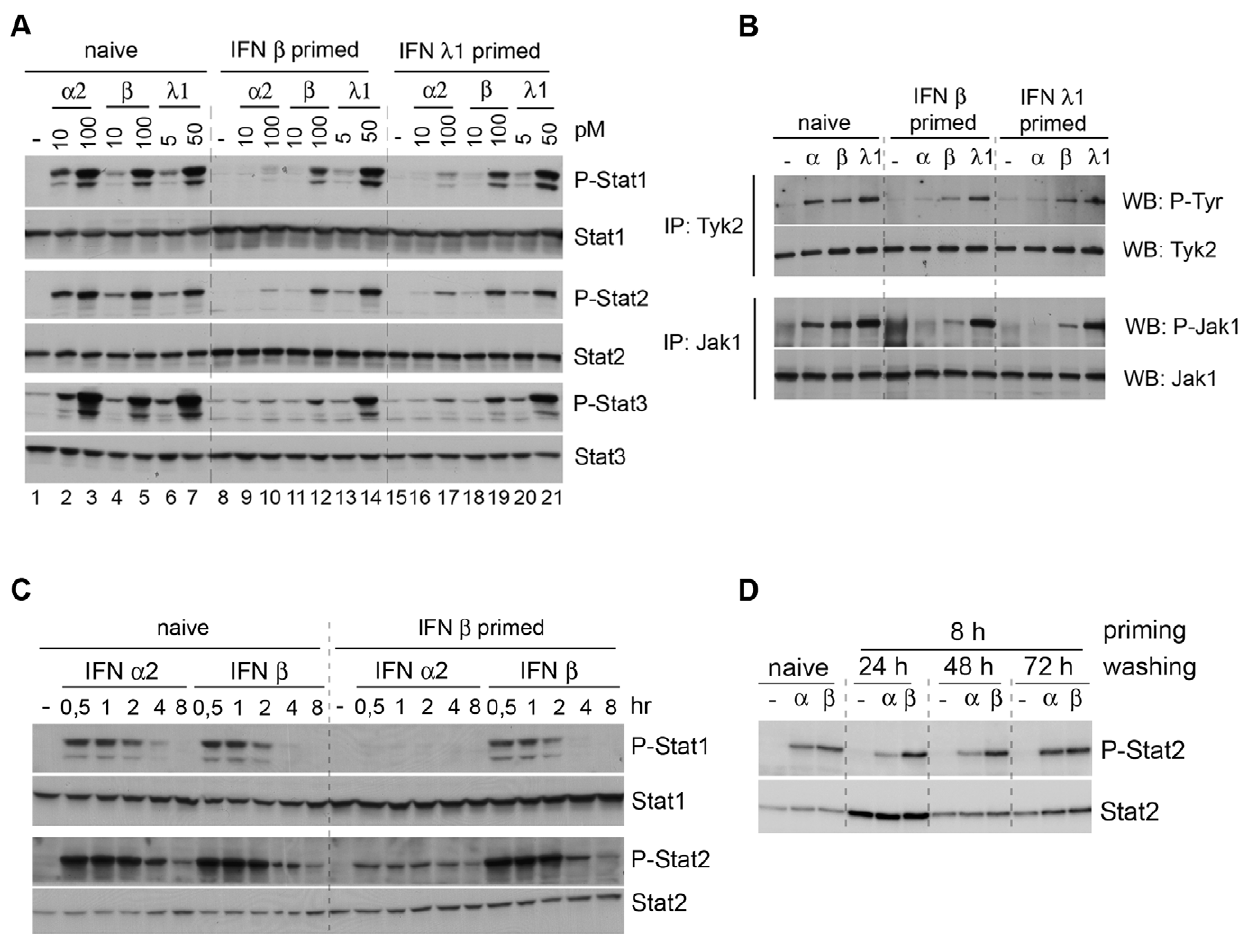
Figure 2. Differential desensitization studies in HLLR1-1.4 cells. (A) Level of phosphorylation of Stat1, Stat2 and Stat3 induced at 30 min by the indicated doses of IFN in naı¨ve cells and in primed cells. Priming was for 8 hr and resting was for 16 hr. Cell lysates (30 m g) were fractionated on a 7% SDS polyacrylamide gel and immunoblotted with the indicated Abs. (B) Level of tyrosine phosphorylation of immunoprecipitated Tyk2 and Jak1 induced at 30 min by IFN a 2 (100 pM), IFN b (100 pM) or IFN l 1 (50 pM) in naı¨ve and primed cells. Priming was for 8 hr and resting was for 16 hr. Lysates (2 mg) were immunoprecipitated with Tyk2 Abs (top) or Jak1 Abs (bottom). The top membrane was incubated with phospho-tyrosine 4G10 mAb (P-Tyr) and the bottom membrane with phospho-Jak1 Abs. Protein content was assessed by re-blotting with Tyk2 or Jak1 specific Abs. (C) Kinetics of Stat1, Stat2 and Stat3 phosphorylation in naı¨ve and primed cells. Cells were stimulated with 50 pM of IFN a 2 or IFN b , as indicated. Priming was for 8 hr and resting was for 16 hr. Lysates (30 m g) were fractionated on a 7% SDS polyacrylamide gel and immunoblotted with the indicated Abs. (D) Level of phosphorylation of Stat2 induced at 30 min by 100 pM of IFN in naı¨ve cells and in primed cells. Priming was for 8 hr and the resting phase varied from 24 hr to 72 hr. Cell lysates (30 m g) were fractionated on a 7% SDS polyacrylamide gel and immunoblotted with the indicated